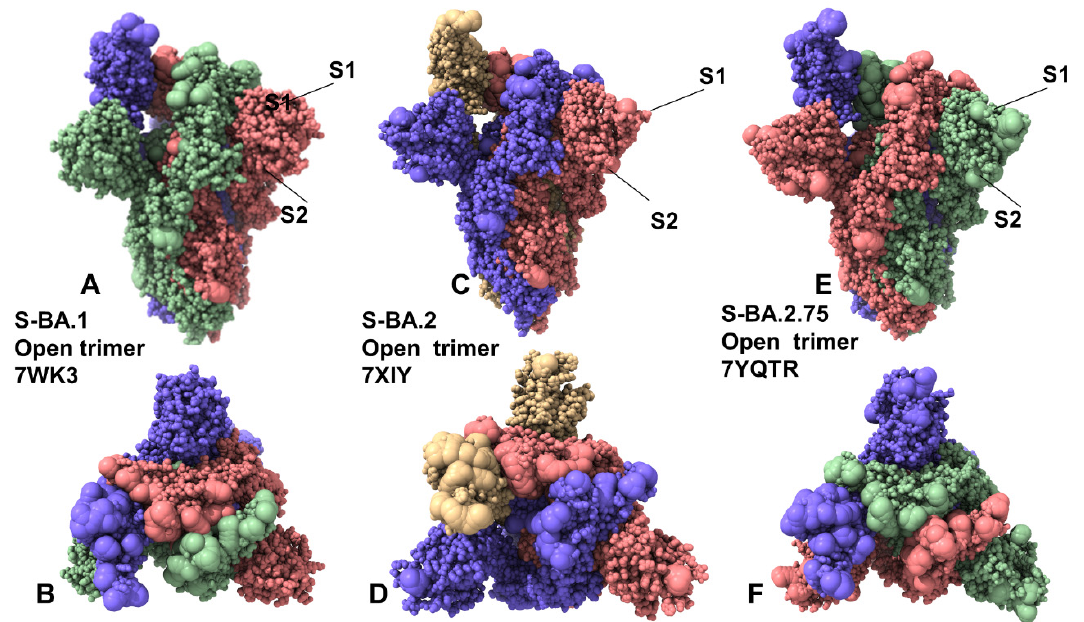
Figure 2. Structural organization and mapping of the Omicron mutations in the SARS-CoV-2 S Omicron BA.1, BA.2 and BA2.75 open trimers. ( A ) The cryo-EM structure of the S Omicron BA.1 trimer in the open 1RBD-up form (pdb id 7WK3). ( B ) The top view of the open BA.1 trimer. The S trimer is shown in full spheres and colored by the protomer. The Omicron BA.1 mutational sites are shown in larger spheres. ( C ) The cryo-EM structure of the S Omicron BA.2 trimer in the open 1RBD-up (pdb id 7XIW). ( D ) The top view of the closed BA.2 trimer. The Omicron BA.2 mutational sites are shown in large spheres. ( E ) The cryo-EM structure of the S Omicron BA.2.75 trimer in the open 1RBD-up form (pdb id 7YQT). ( D ) The top view of the closed BA.2.75 trimer. ( F ) The top view of the closed S Omicron BA.2.75 trimer. The Omicron BA.2.75 sites are shown in larger spheres. Table 1. Mutational landscape of the Omicron mutations for BA.1, BA.2, and BA.275 variants. SARS-CoV-2 Omicron Variant Mutational Landscape of the